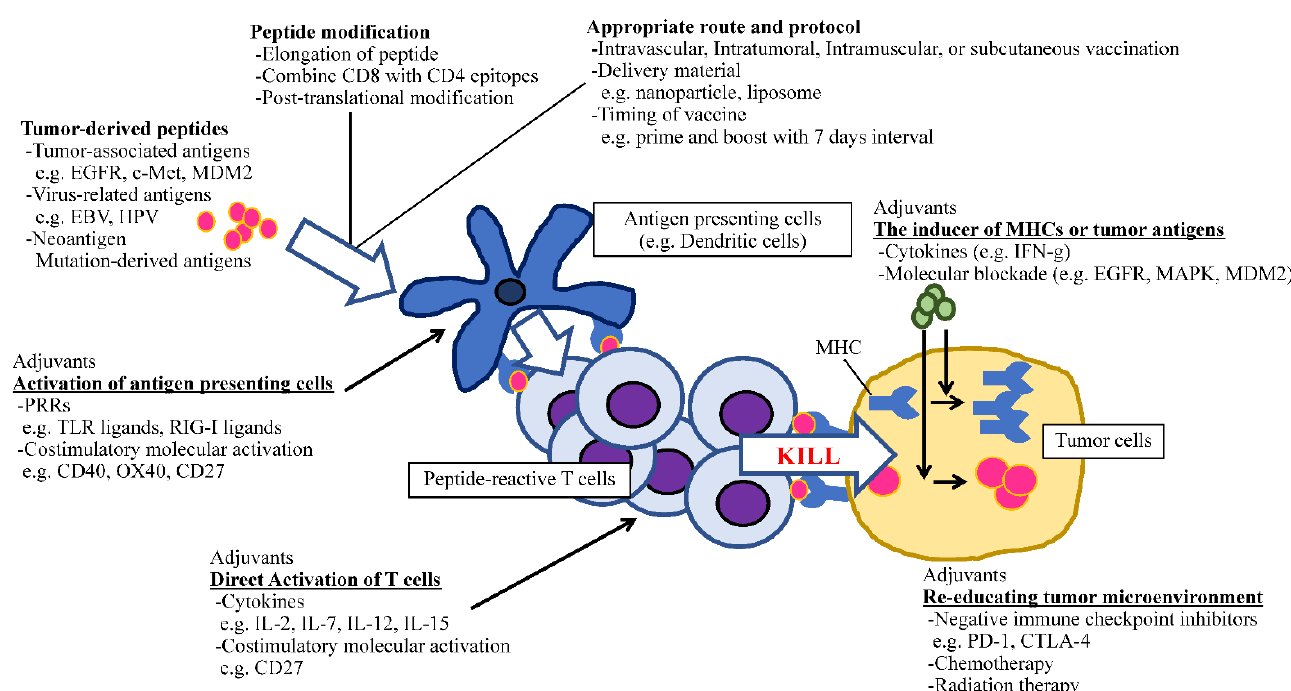
Figure 1. The schematic of optimizing peptide vaccines.